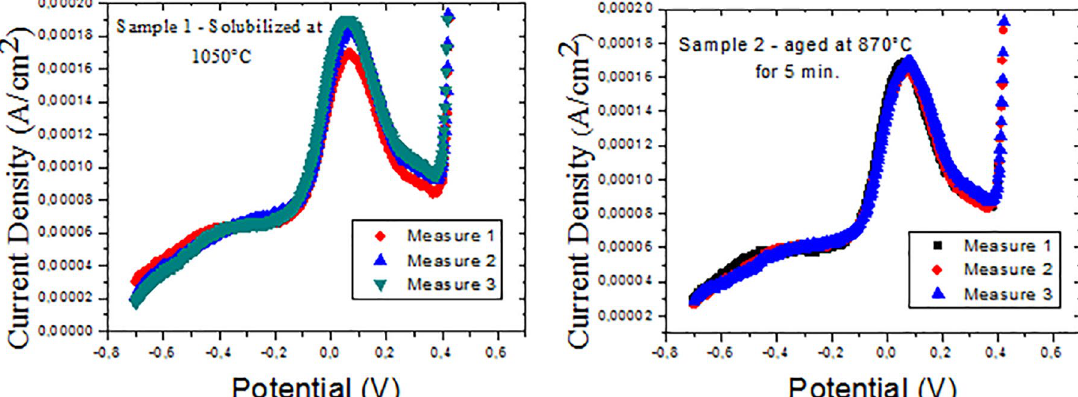
Figure 6. Linear Sweep Voltammetry of steel UNS S31803 in different heat treatment conditions in 3 mol/L KOH solution and 2 mV / s scan rate. density. However, the current peak at 0.045 was not observed, a temporary phenomenon indicating its relation with some metastable phase such as the chi phase, which is a metastable phase of DSSs 16 as well as the appearance of the third peak at 0.15 V should be related to sigma phase